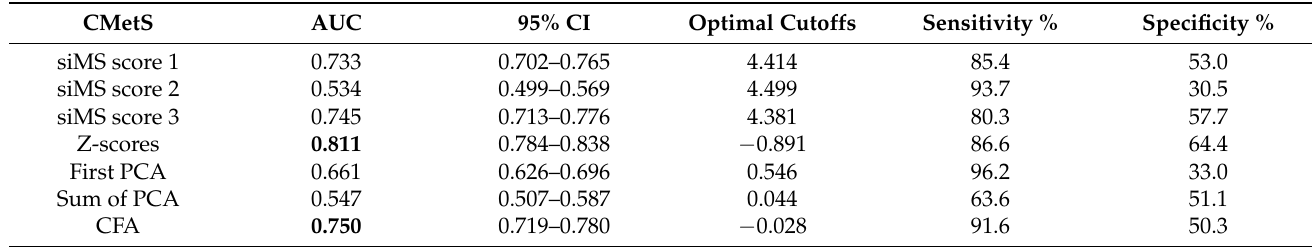
Table 4. ROC curve analysis for cMetS scores as determinants of